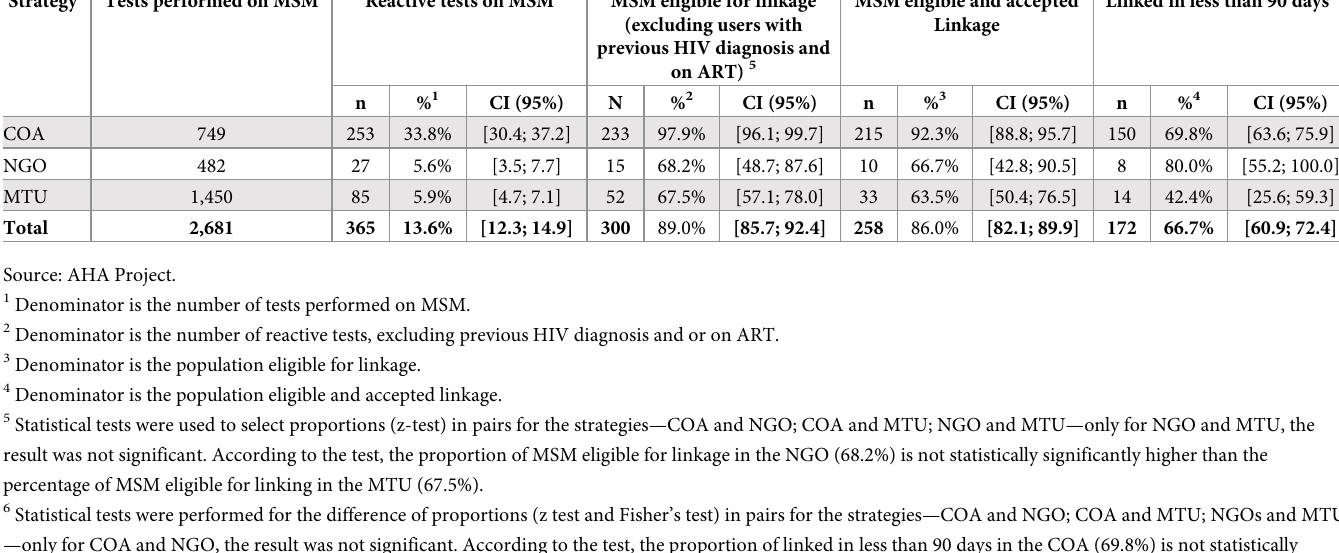
Table 2. Distribution of tests carried out by the MSM in accordance with the AHA´s strategies—Curitiba/PR/Brazil—03/01/2015 to 03/31/2017. Strategy Tests performed on MSM